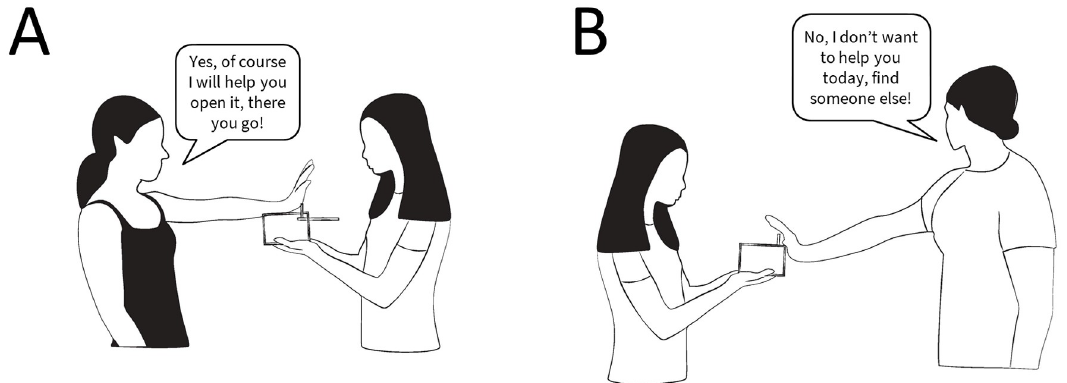
Fig 3. Illustration of the beggar interacting with (A) the helpful person and (B) the unhelpful person. By Hoi-Lam Jim and Nadja